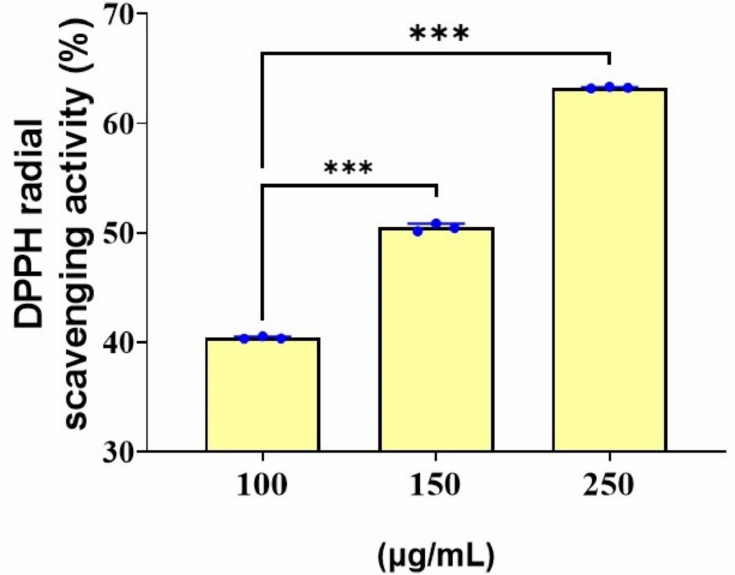
Figure 9. The figure shows the DPPH antioxidant activity of the isolated Spirulina sp. *** p < 0.001. The student’s t -test was used for